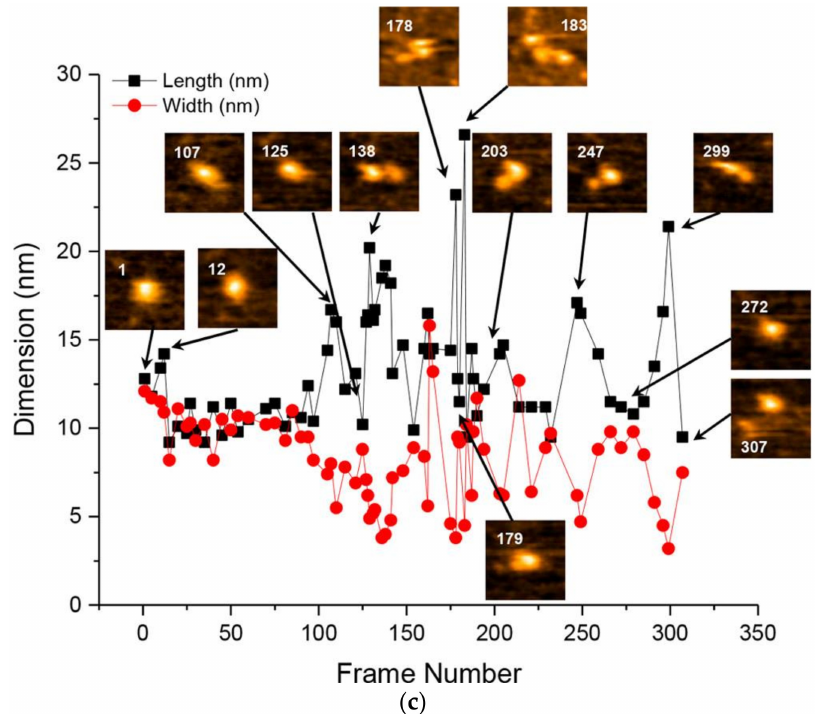
Figure 8. HS-AFM images of A β 42 oligomers. Time courses of width and length obtained from HS-AFM images at the indicated times for trimers ( a ), pentamers ( b ), and heptamers ( c ). Reprinted with permission from [109]. Copyright (2017) American Chemical Society.